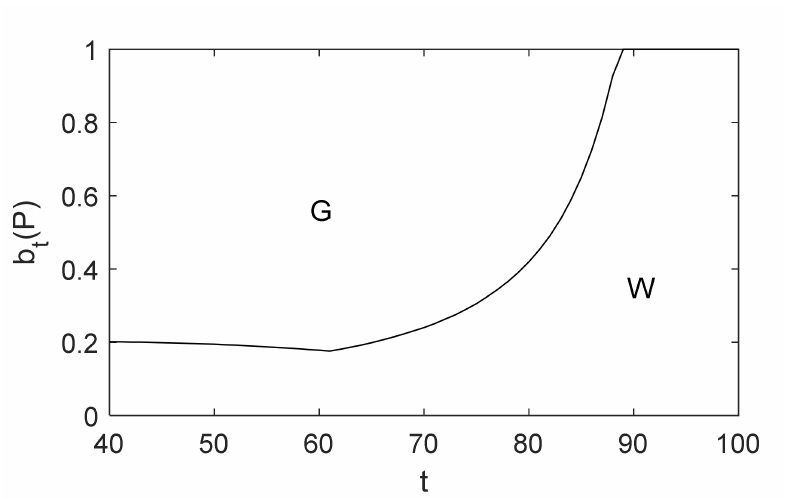
Figure 3. Optimal policies for